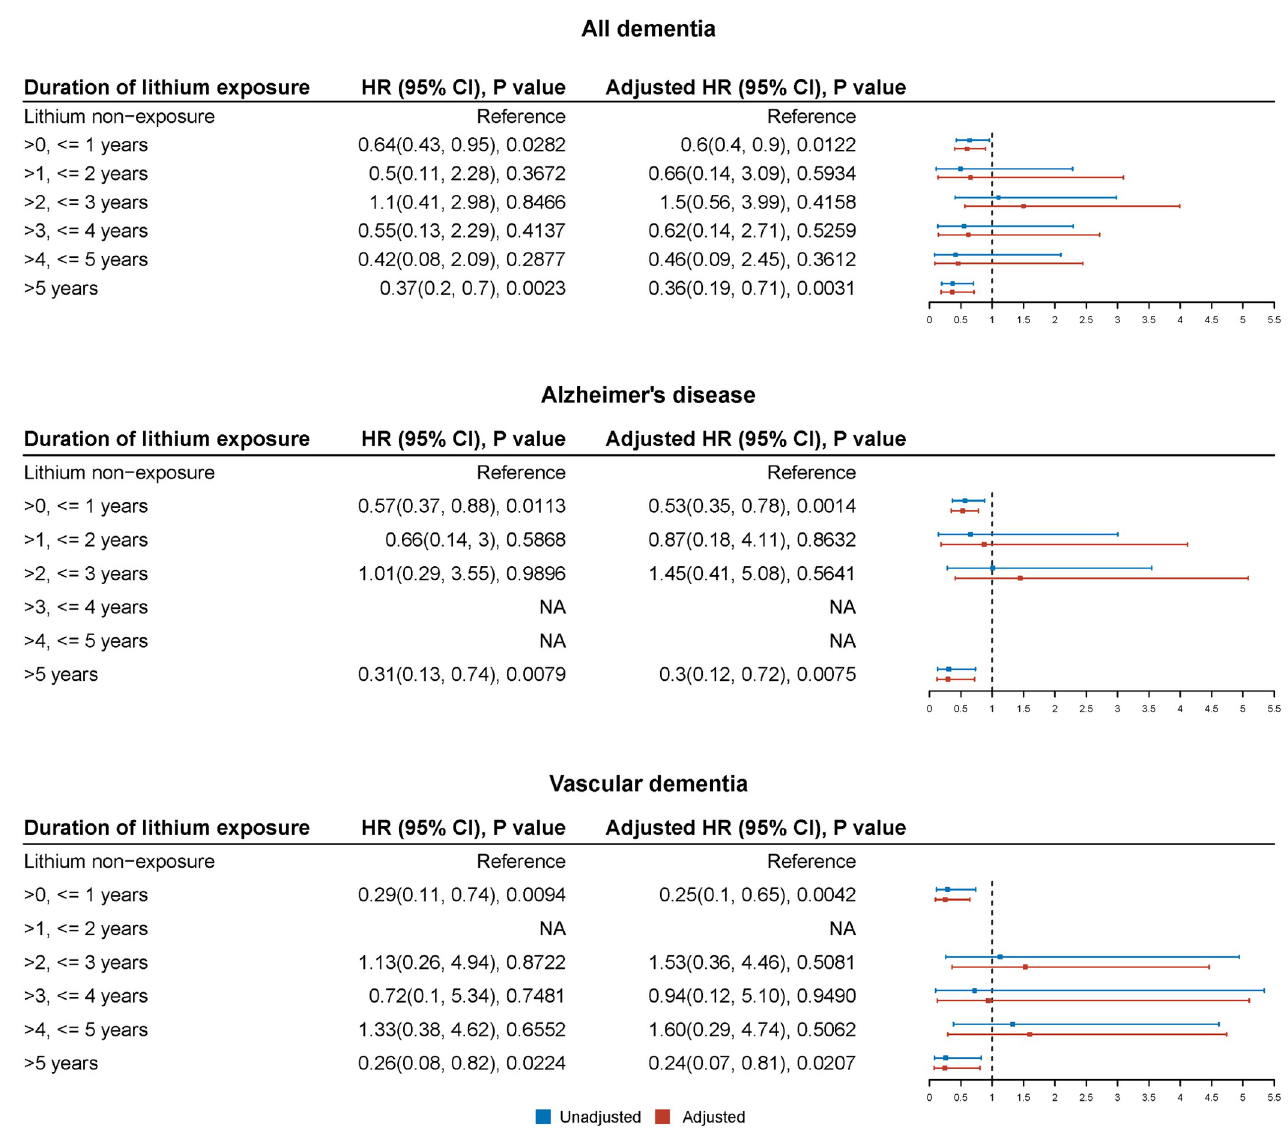
Fig 4. HRs, 95% CIs, and p -values for the association of duration of lithium exposure with the development of dementia (and its subtypes) by Cox proportional hazards models. HRs, 95% CIs, and p -values were extracted from inverse probability weighted Cox regression. Adjusted HRs were adjusted for age, sex, marital status, ethnicity, smoking status, alcohol disorders, antipsychotic use, depression, mania or BPAD, hypertension, central vascular disease, diabetes mellitus, and hyperlipidemias. NA indicates no result (no corresponding cases). The AIC was 14,125 for the model fitted for all dementias, 13,064 for the model fitted for AD, and 13,119 for the model fitted for VD. See Fig Q in S1 Appendix for an equivalent analysis using pooled intermediate durations and Fig R in S1 Appendix for the effects of lithium exposure duration as a continuous variable. AD, Alzheimer disease; AIC, Akaike information criterion; BPAD, bipolar affective disorder/mania; CI, confidence interval; HR, hazard ratio; VD, vascular dementia.